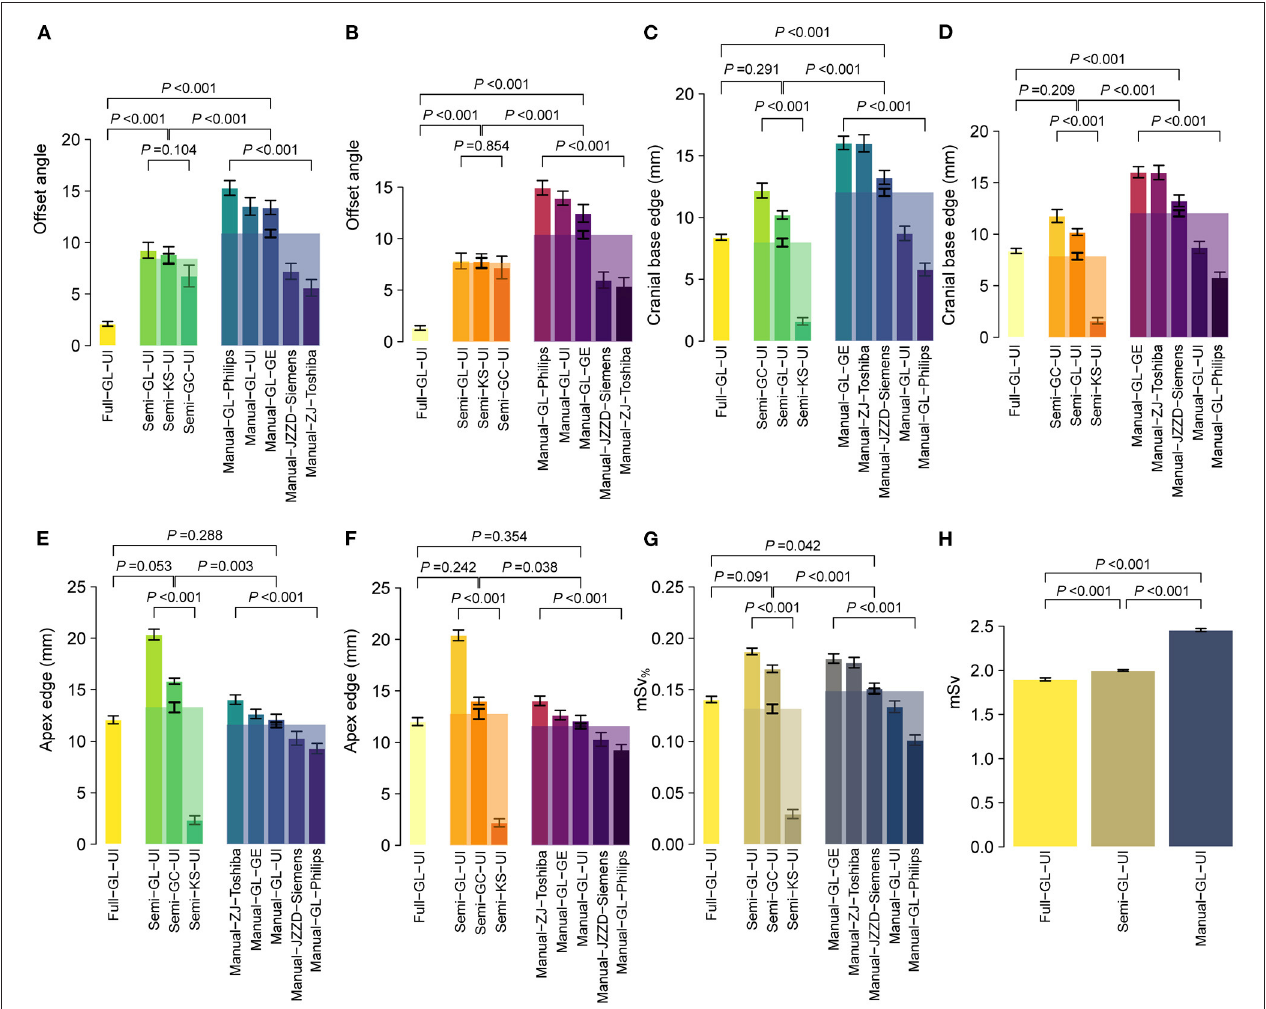
FIGURE 4 | Performance of CAPITAL-CT under three clinical scenarios regarding multiple aspects, including (A,B) offset angle, (C,D) apex, and (E,F) cranial base edge, (G) additional mSv % , and (H) absolute mSv % . Bars here present the mean ± standard error of the mean (SEM), and bars with transparent colors were generated by pooling data from multiple hospitals under specific scenarios. Statistical P -values were calculated by a two-sample Student’s t -test or one-way ANOVA for multiple group